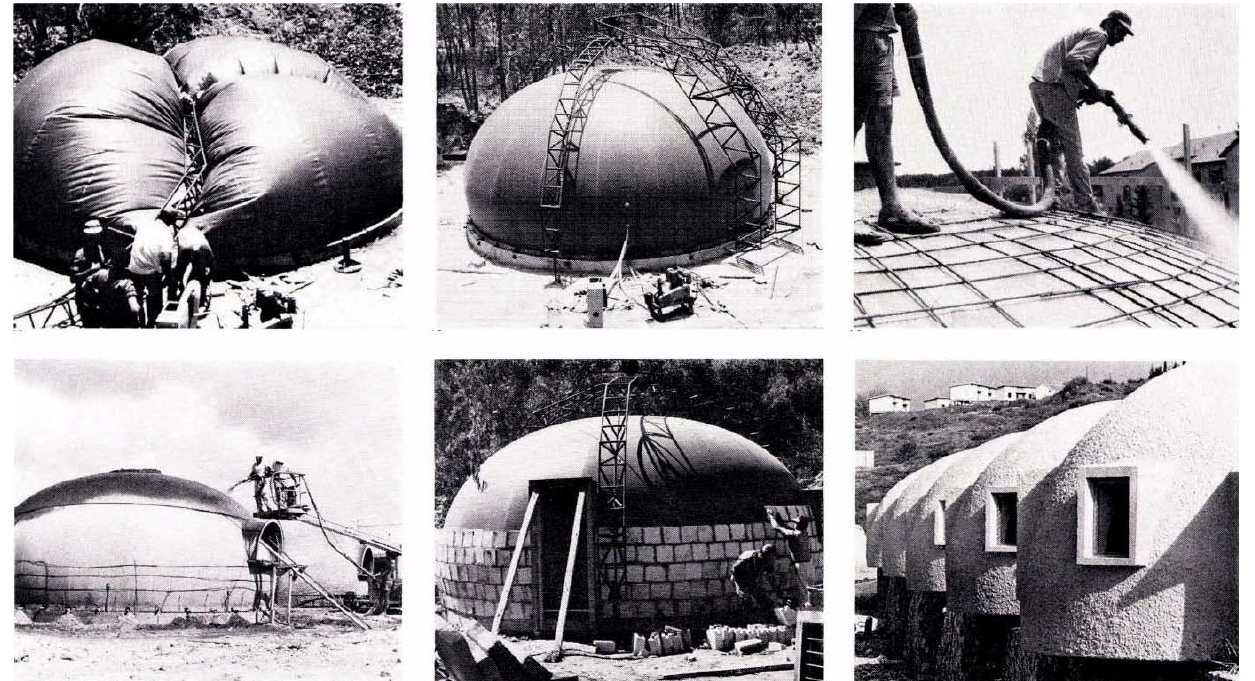
Figure 8: Domecrete construction method invented by Heifetz [12].